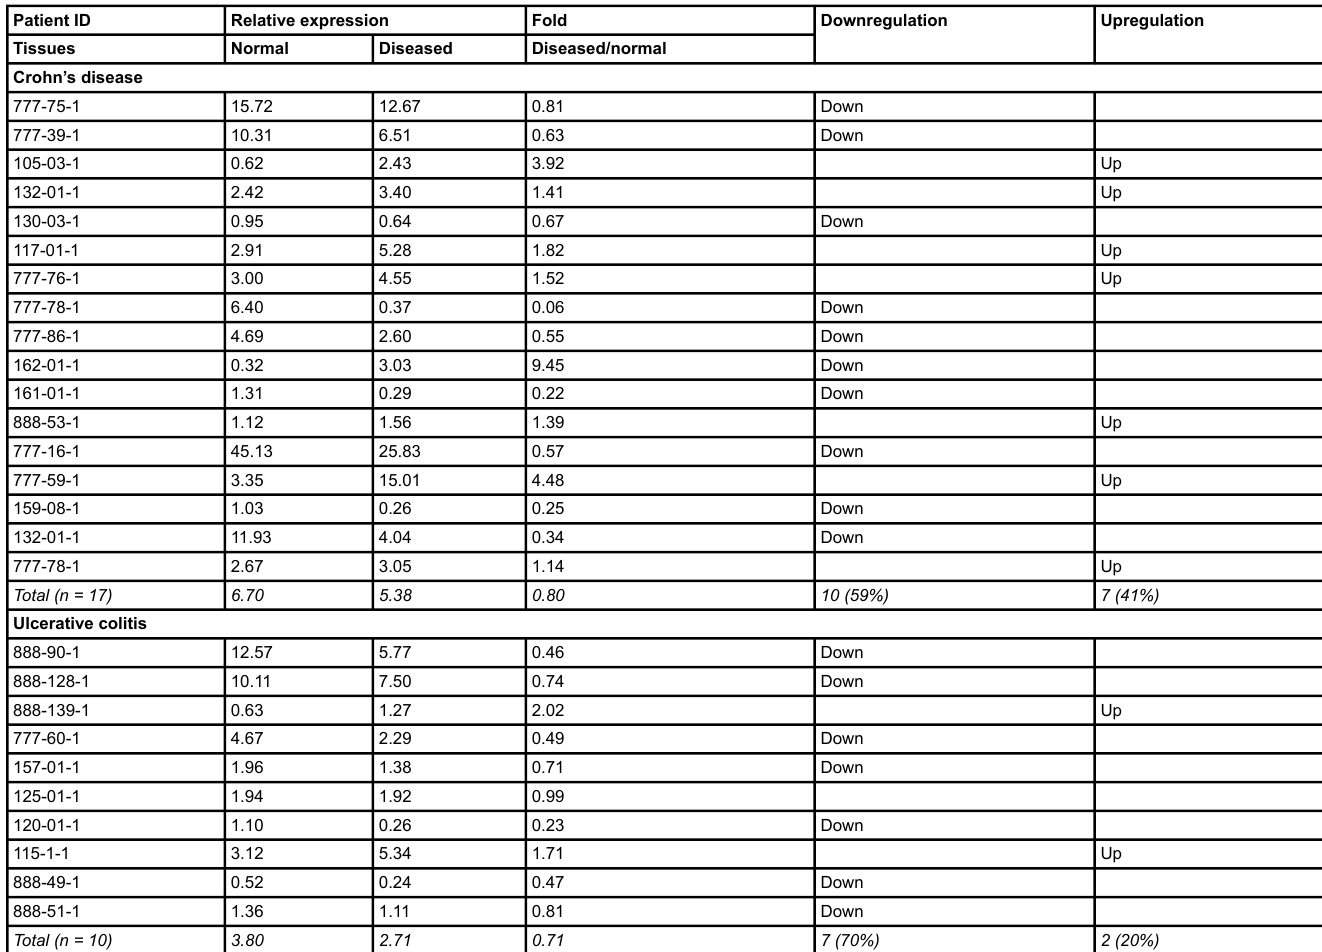
Table 5: Ho-1 gene expression in diseased tissues from adult patients with inflammatory bowel disease. Patient